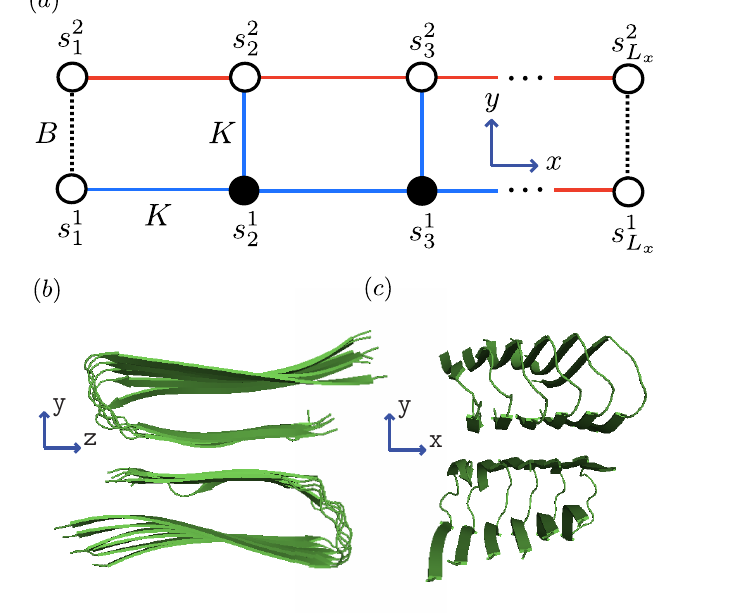
( a ) Front-view ( y - z plane) of a strip lattice representing an aggregate of A β (1-40) proteins. Black circles corresponds to coil proteins while white circles denote sheet or helix proteins. Dashed lines represent interactions between proteins in the y -direction whereas solid lines are the interactions between proteins along the x -axis; ( b ) Side-view ( x - y plane) of A β -40 proteins illustrating the steric zipper; and ( c ) strip lattice representation of the A β -40proteins, where the parameters B and K are